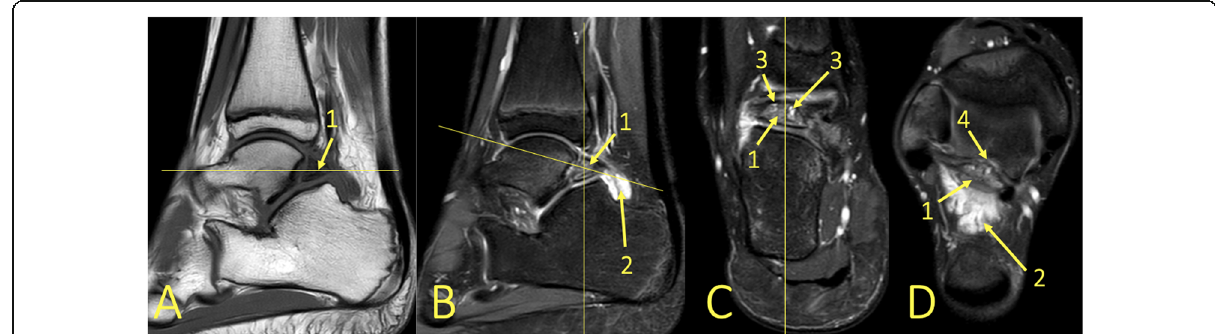
Fig. 21 A 16-year-old male with chronic posterior ankle pain and a suspected os trigonum with impingement. (1) MRI showed an os trigonum with BME, (2) effusion and synovitis, and (3) degenerative cysts (4) along the articulation with the posterior talar process